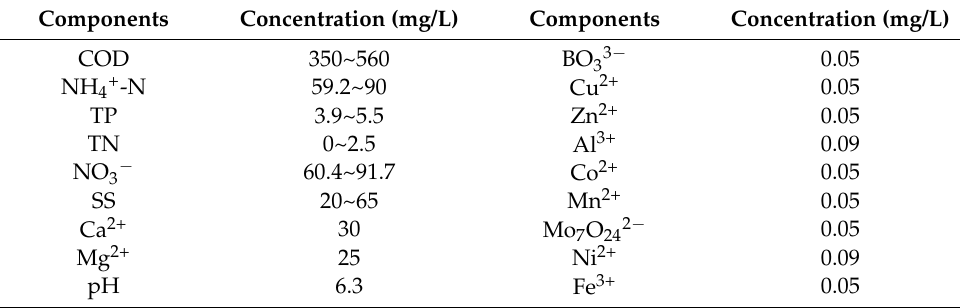
Table 1. The characterization of the treated